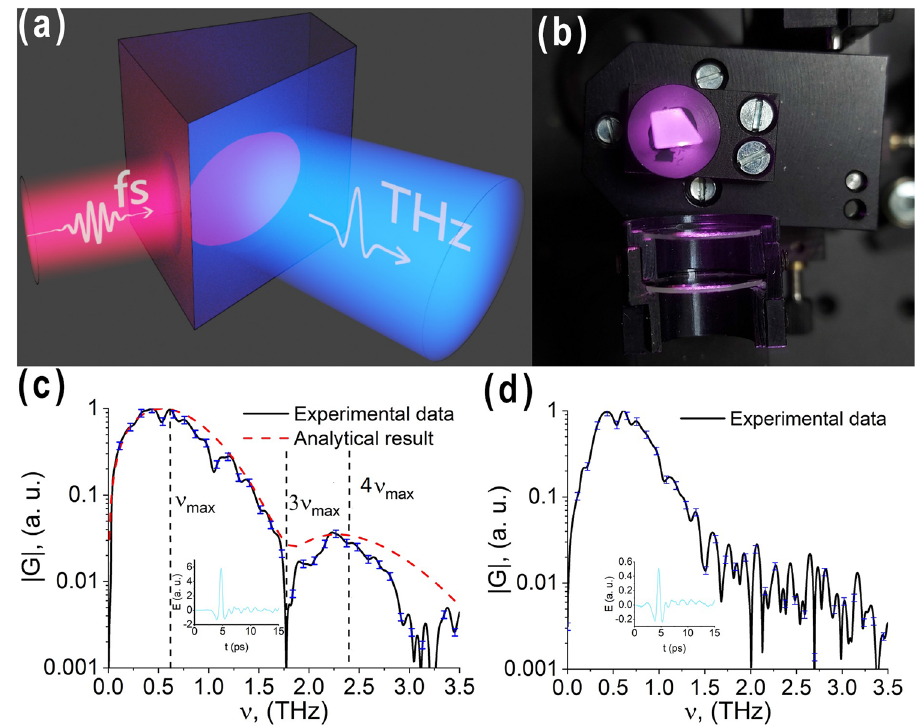
Figure 1. ( a ) Generation of the THz pulse by optical rectification. ( b ) Image of the generation of a THz pulse by the optical rectification method in MgO: LiNbO 3 crystal. ( c ) Spectrum of the generated THz field. The black solid line is the experimental data for high pump intensity, the red dotted line is the analytical results, the blue dashes show the experimental data error. ( d ) Spectrum of the generated THz field for lower pump intensity. Insets in ( c,d ) illustrate the temporal profile of the THz pulse at the output of the